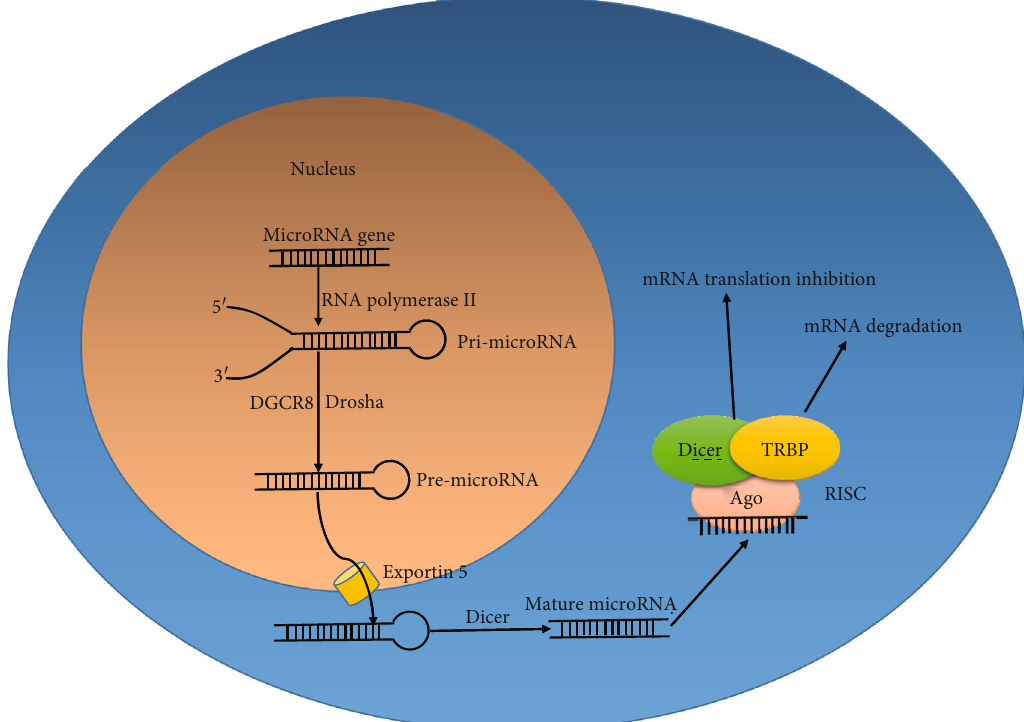
Figure 1: The process of microRNA biogenesis. MicroRNA genes are fi rst transcribed into pri-microRNA by RNA polymerase II. In the nucleus, pri-microRNAs are cleaved by an RNase III enzyme called Drosha and its cofactor DGCR8 into pre-microRNAs. Then, the pre- microRNA is exported into the cytoplasm by Exportin 5. In the cytoplasm, the pre-microRNA is cleaved by another RNase III enzyme Dicer to produce a mature 22 nucleotide long double-stranded microRNA duplex. The functional strand of the microRNA is assembled into RISC, which leads to mRNA degradation or inhibition of translation of its target